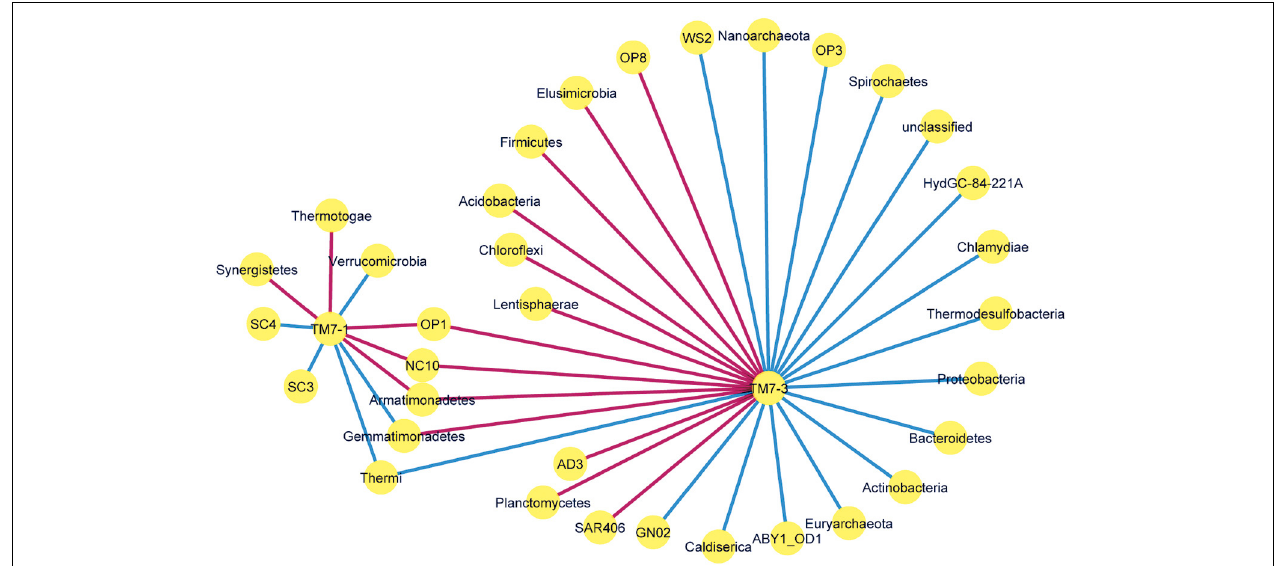
FIGURE 4 | Network co-occurrence analysis of the TM7 classes, TM7-1 and TM7-3 with respect to bacterial phyla present in the polar soil dataset. Only significant relationships are shown. Edges are blue if the relationship between nodes is positive and red if negative.